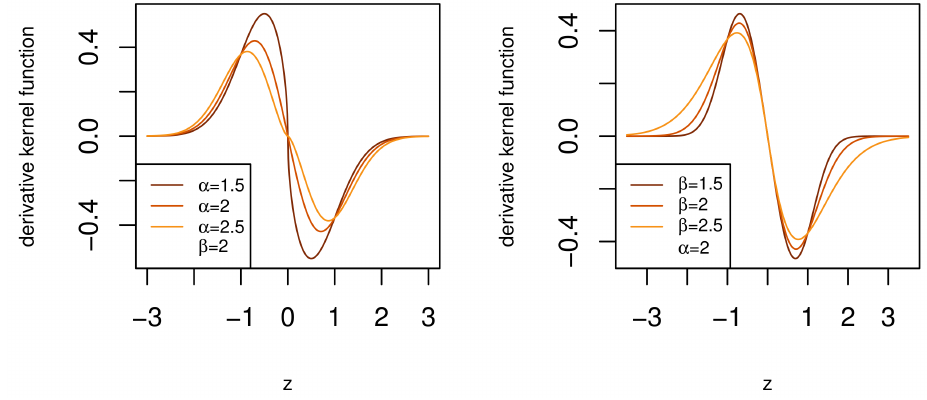
Figure 3. The derivative kernel function of body-tail generalized normal (BTGN)